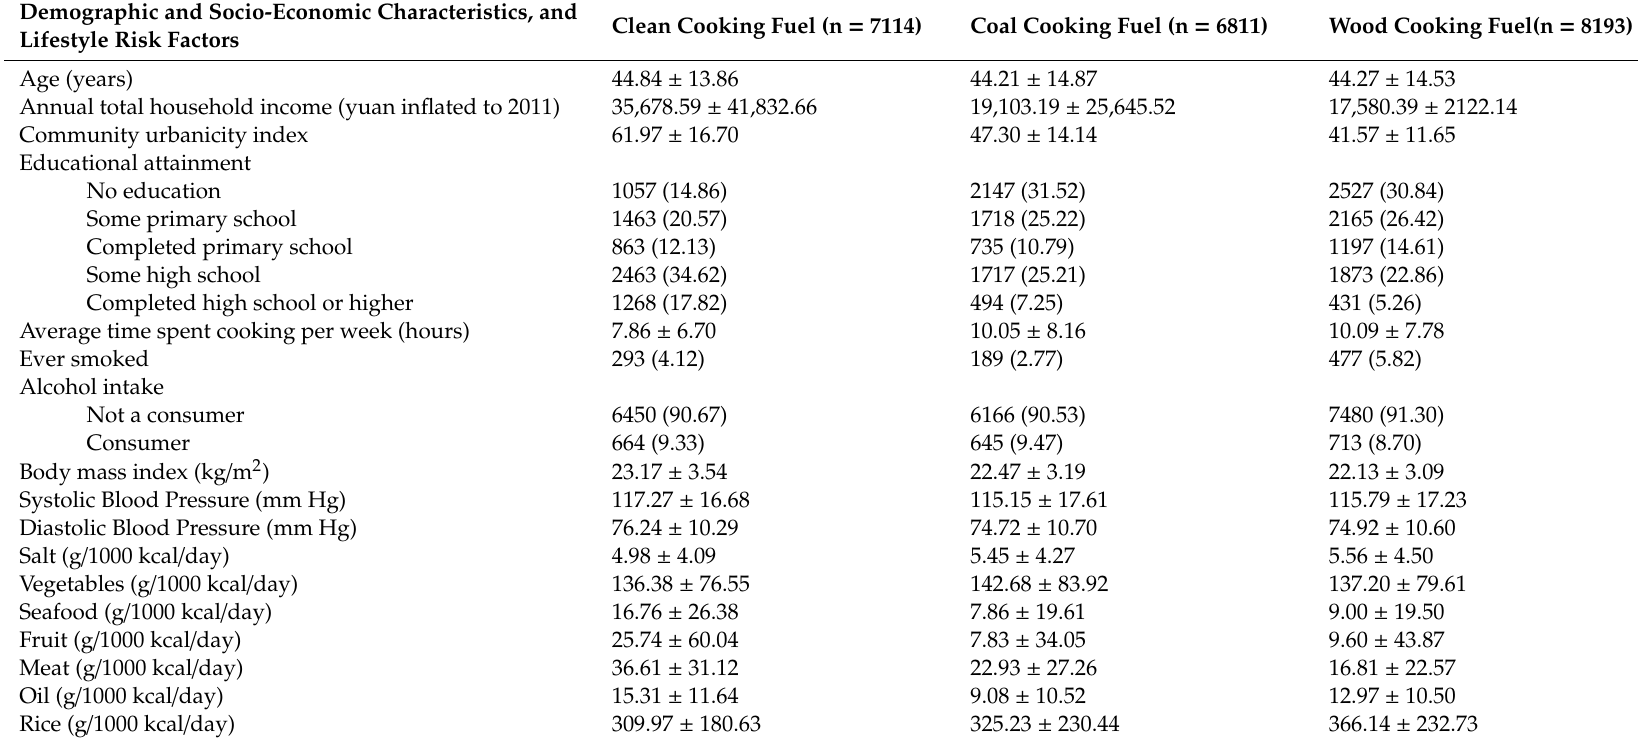
Table 1. Characteristics according to cooking fuel category (n = 22,118 observations from n = 6671 women, median observations per woman 3). Demographic and Socio-Economic Characteristics,